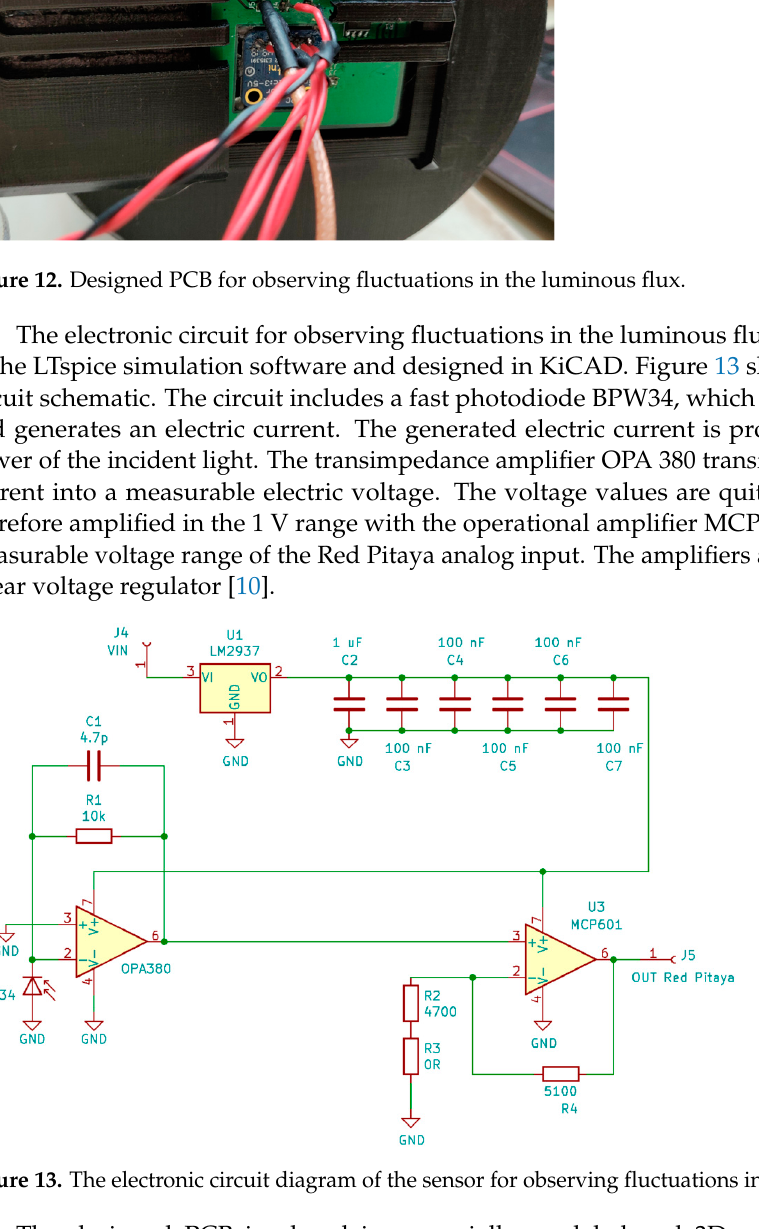
flux. The designed PCB is placed in a specially modeled and 3D-printed tunnel lid